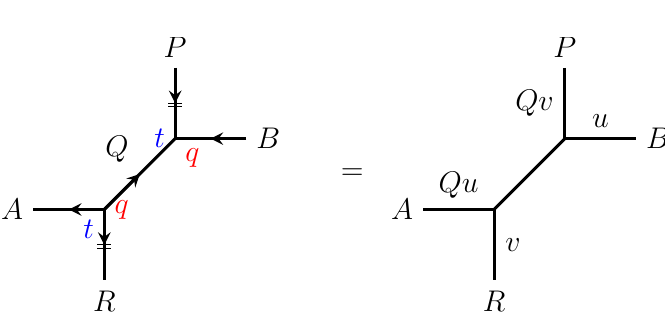
Figure 5 . Resolved conifold geometry in re(cid:12)ned topological strings. The double ticks denote the preferred direction, and t and q indicate the respective legs of the re(cid:12)ned topological vertices. Q is the exponentiated complexi(cid:12)ed K(cid:127)ahler parameter of the base P 1 (drawn as an intermediate diagonal edge). A , B , P and R are Young diagrams associated with the outer legs. The right picture is the simpli(cid:12)cation of the left one with spectral parameters on the legs playing the roles of K(cid:127)ahler parameters.